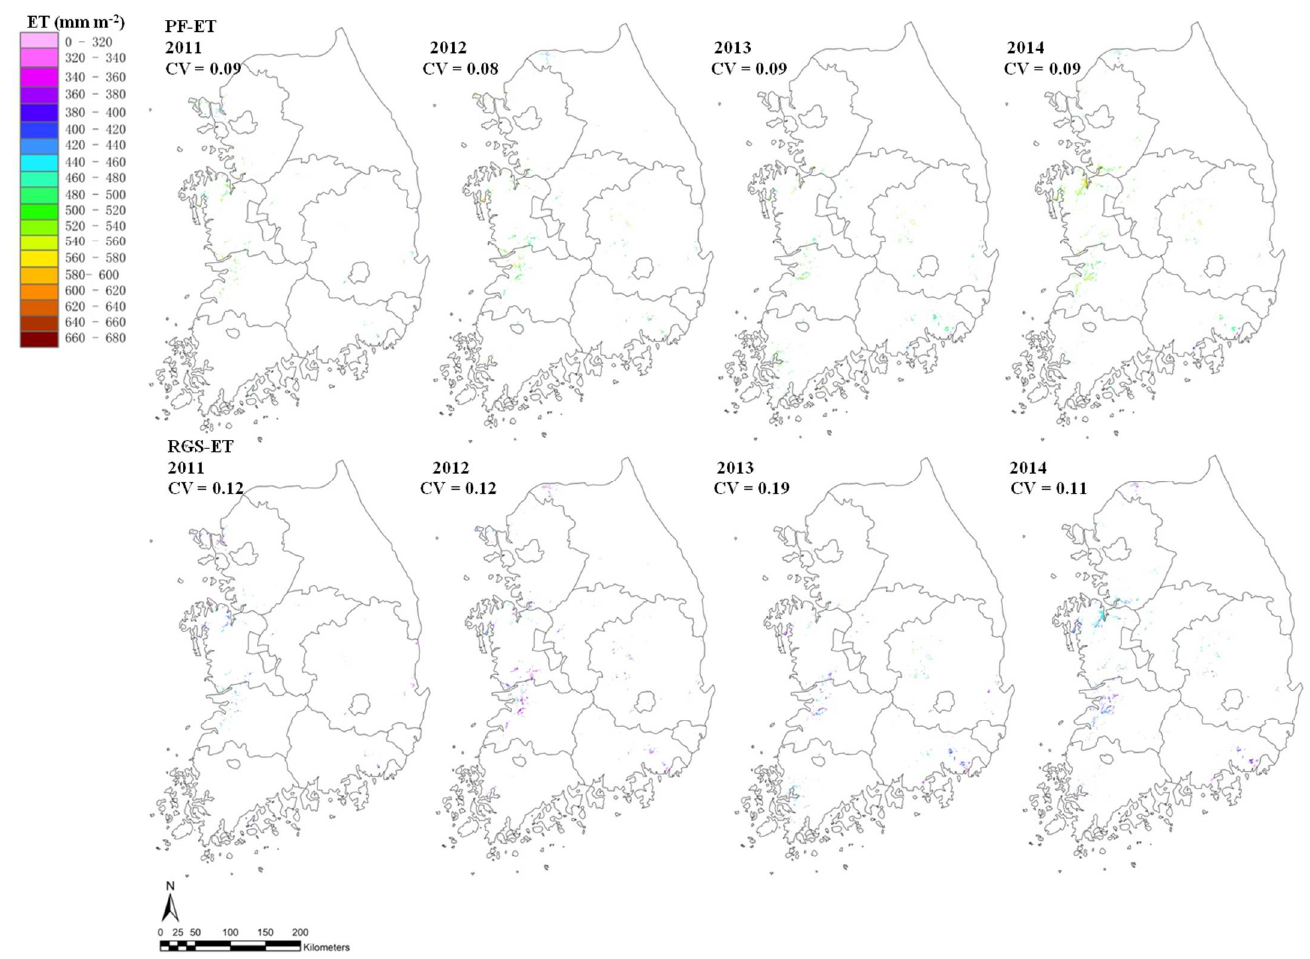
Figure 4. Spatial variations of paddy field total ET ( PF-ET ) and the rice-growing season total ET ( RGS-ET ) from 2011 to 2014 in South Korea. PF-ET : the sum of daily ET from the FFTD sat to the EGS (mm m –2 ); RGS-ET : the sum of daily ET from the SoS to the EGS (mm m –2 ); CV : the coefficient of variation. EGS : the seasonal onset of the rapid canopy expansion (DOY); FFTD sat : the first flooding and transplanting date detected by satellite remote sensing (DOY); DOY : the day of year.